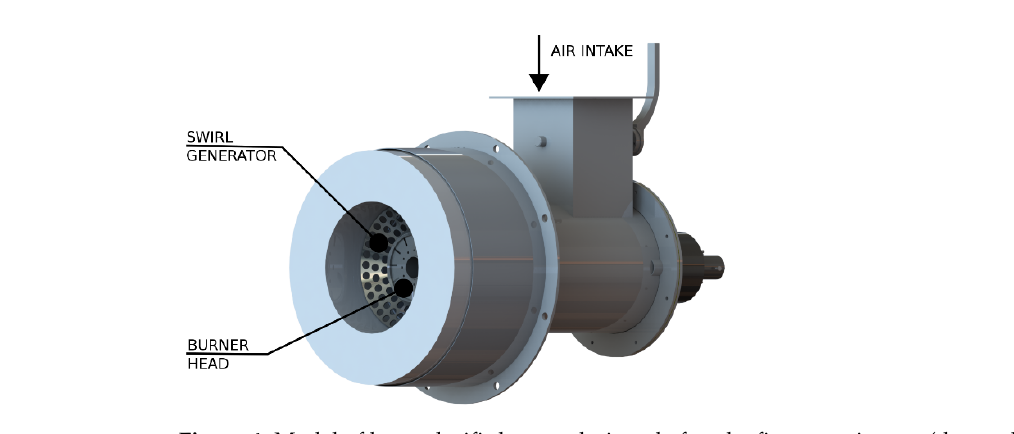
Figure 4. Model of low-calorific burner designed after the first experiments (denoted as Burner C). Different operational parameters were observed in the experiment. In the first test (TEST A), the influence of CO 2 and N 2 addition into the noble fuel on NO x emissions, flue gas temperature, and flame stability was investigated. Due to the different burner geometries, which limited the overall fuel amount that could be burned under certain conditions, an experimental matrix for each test was created to show the differences between the experiments. After each change in the combustion parameters, the combustion chamber operated for 30 min before the measurements were recorded in order to eliminate the fluctuations in the data and ensure optimal results. Furthermore, all the stated emission results were measured at 3% O 2 in the flue gas at the sampling spot in the flue gas duct before connecting to the chimney. The technological scheme of the combustion chamber is shown in Figure 5.